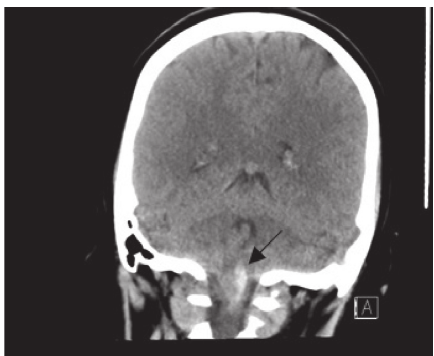
Figure 1: Coronal computed tomography (CT) image of the head demonstrating hyperdense intra-axial hemorrhage at the left cer- vicomedullary junction (arrow).